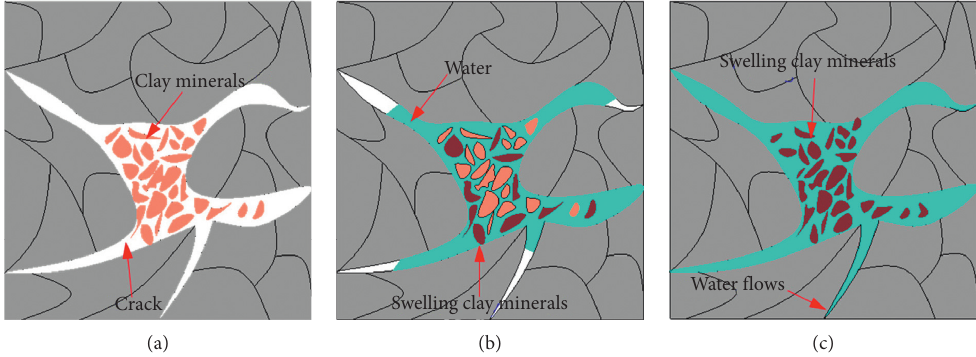
Figure 12: The water absorption process of clay minerals: (a) dry state, (b) water absorption state, and (c) saturation